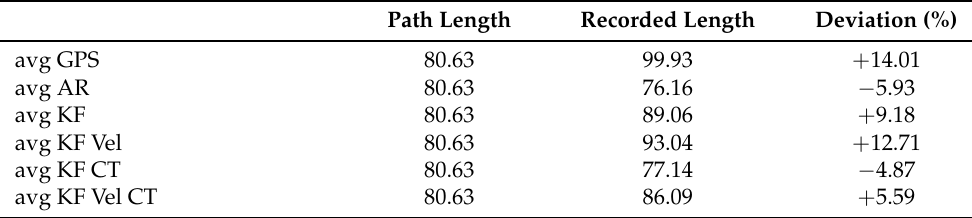
Table 10. Evaluation (Dataset 1): GPS and AR; length-related data.